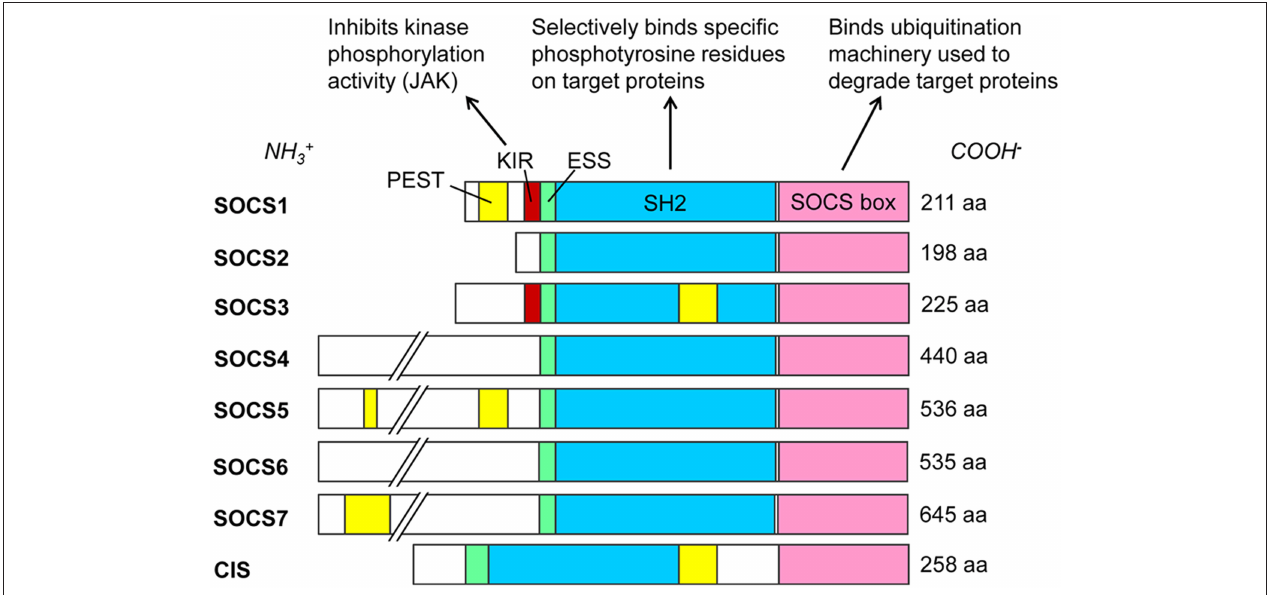
FIGURE 1 | SOCS family proteins and their domains. Src homology 2 (SH2) domains (blue) govern target protein specificity by recognizing phosphorylated tyrosine residues flanked by specific sequences such as those on cytoplasmic residues of cytokine receptors. SOCS1 and SOCS3 exclusively contain kinase inhibitory regions (KIR, red), which bind and inhibit JAK proteins. Extended SH2 sequences (ESS, green) enhance binding specificity and affinities to phosphotyrosine residues. SOCS box domains (pink) recruit cellular Elongin BC, Cullin5, and RING-box-2 to form an E3 ubiquitin ligase complex, ubiquitinating target proteins for proteasomal degradation. PEST motifs (yellow) greatly decrease the half-lives of the proteins; see ( 35, 36) for predicted PEST domain locations. Amino acid (aa) lengths for Homo sapiens SOCS proteins are from the National Center for Biotechnology Information (NCBI) database (February